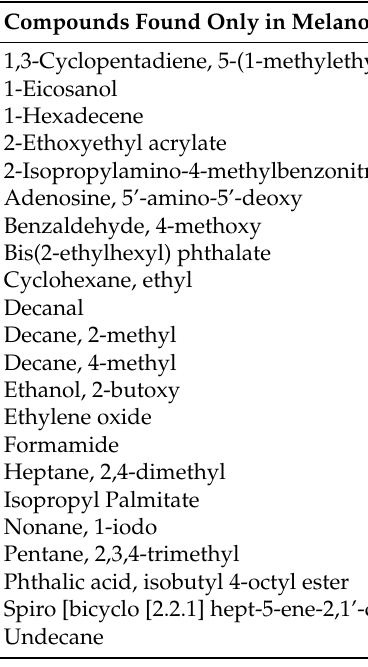
Table 3. 23 Volatile compounds found only in